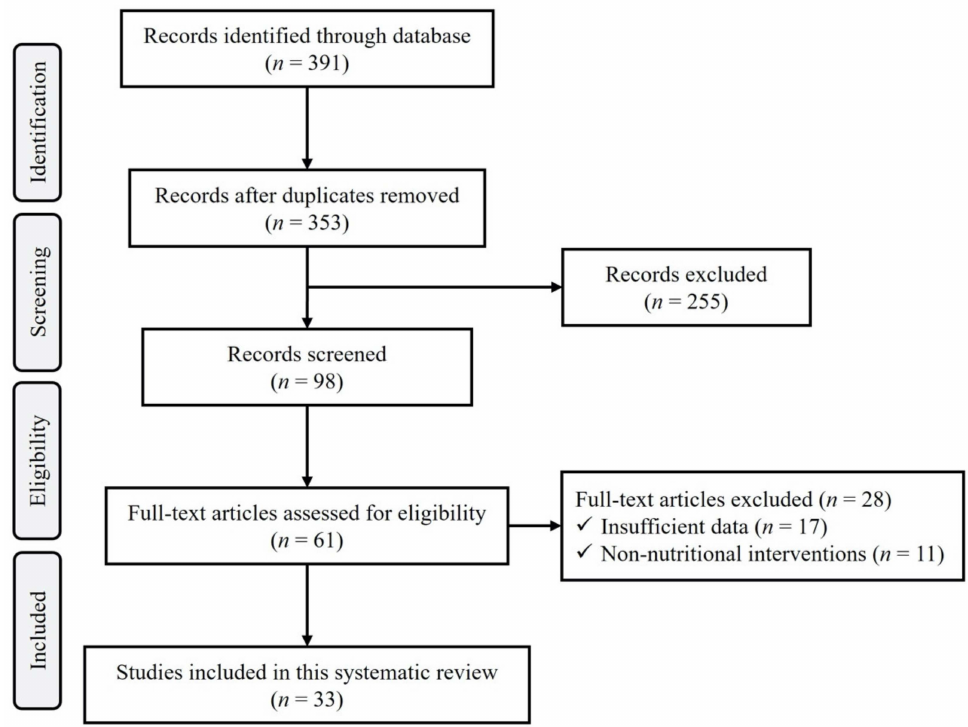
Figure 3. PRISMA flow diagram. Studies were identified through databases search in PubMed, Embase, Web of Science, and Science Direct. Of the 420 studies identified, only 62 were included in this systematic